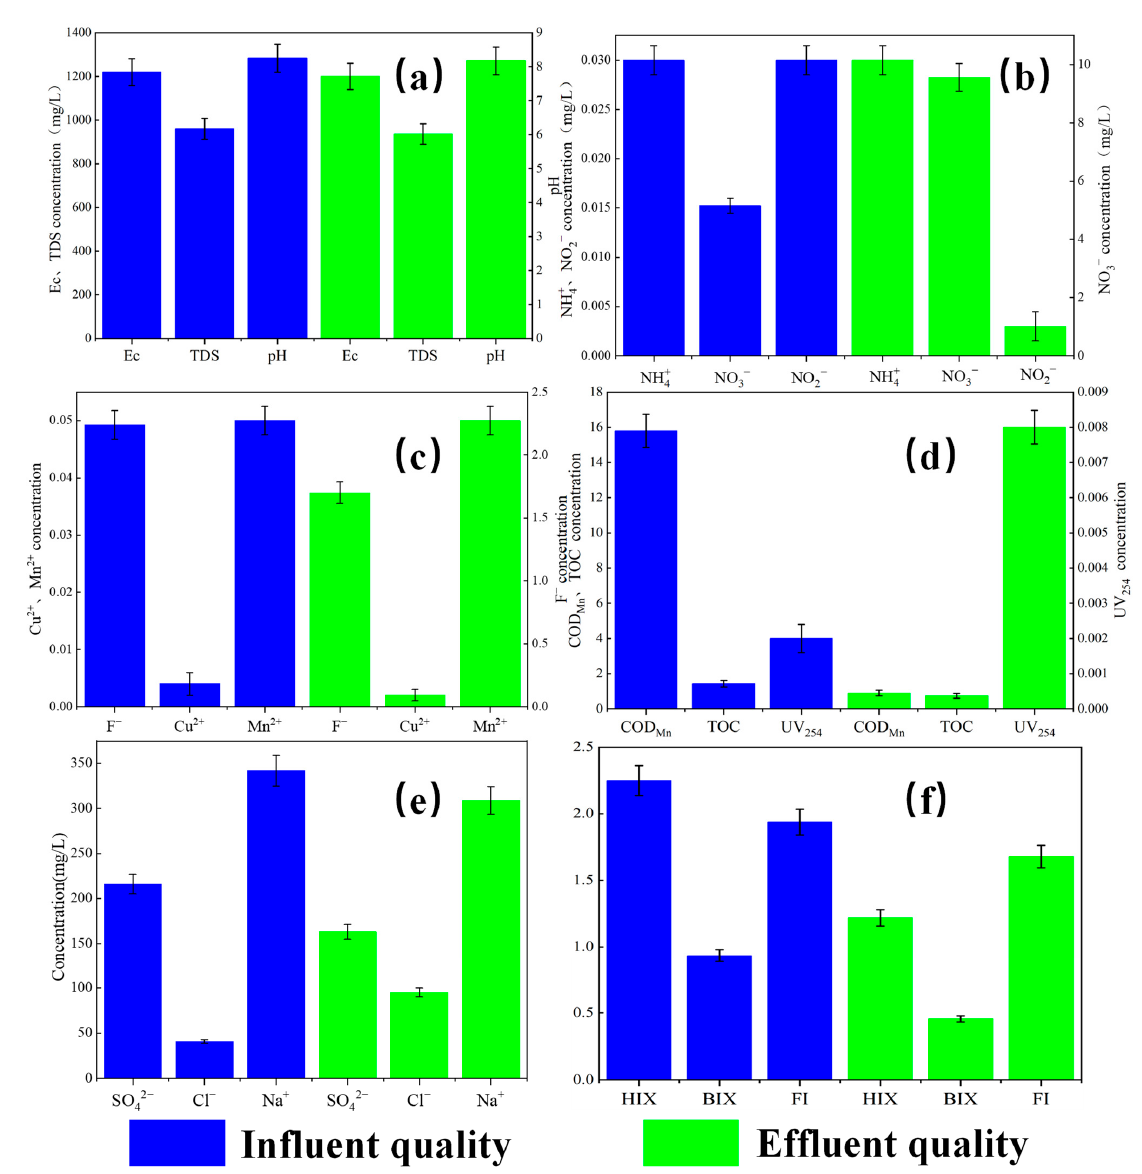
Figure 6. Characteristics of influent and effluent water quality at the Caojiatan mine water treatment station. ( a , c , e ) are inorganic components of the mine water; ( b , d , f ) are the organic